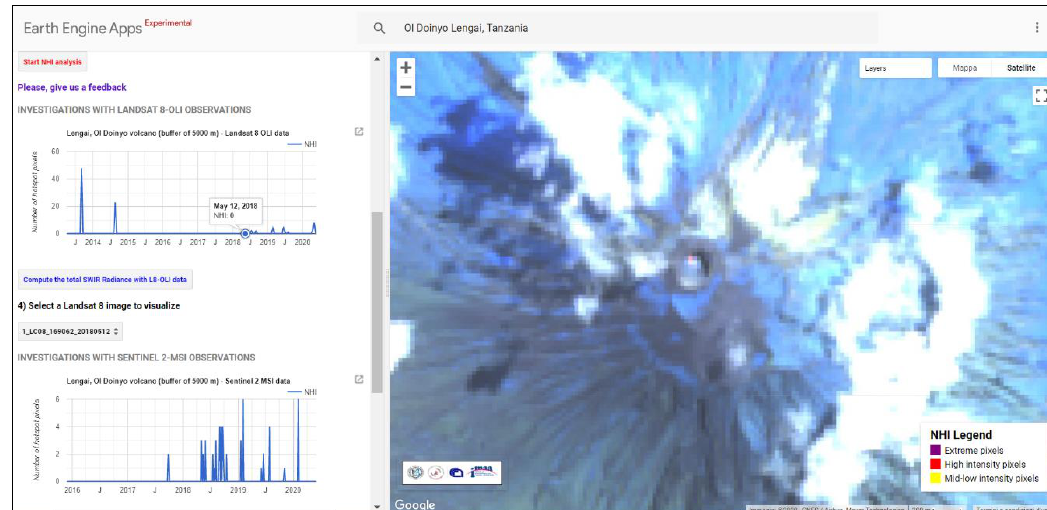
Figure 11. Oldoynio Lengai ( 2°45′00″S 35°55′12″E ) thermal activity of April 2013 − May 2020, and thermal anomaly map of 12 May 2018, showing an intra-crater thermal anomaly (indicated by the black arrow) undetected by the tool, regardless of used version.